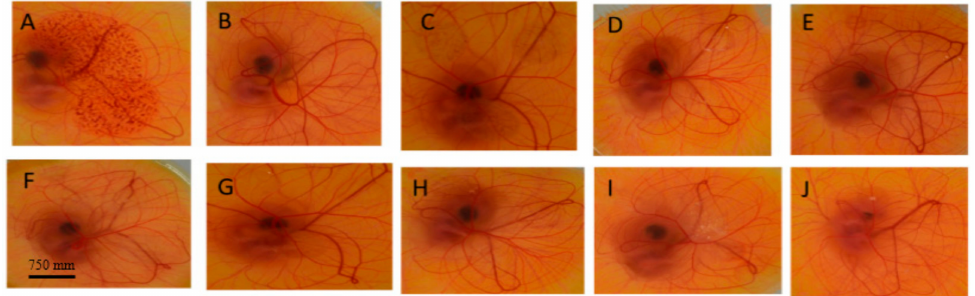
Figure 10. Effect of controls and test substances on the surface of the chorioallantoic membrane (CAM) after treatment for 5 min ( A ) NaOH, ( B ) Normal saline, ( C ) Transcutol P, ( D ) Tween 80, ( E ) microemulsion (T1), ( F ) microemulsion (T2), ( G ) microemulsion (T3), ( H ) microemulsion (C1), ( I ) microemulsion (C3), ( J ) microemulsion (C2).